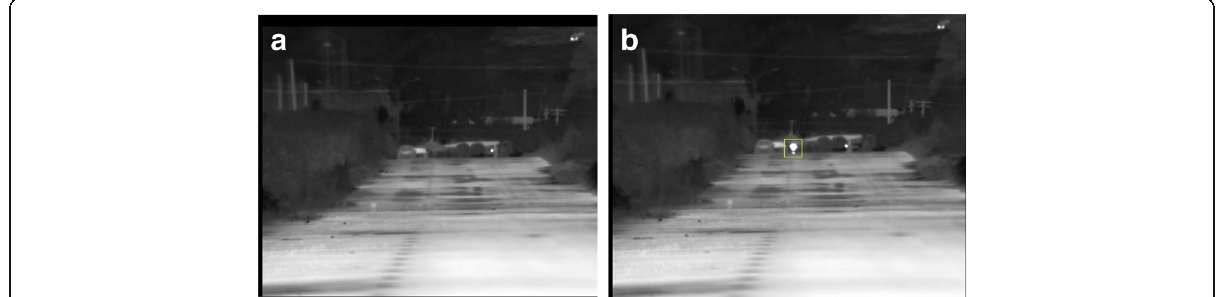
Fig. 18 Effect of laser illuminance at close range on a small divergence